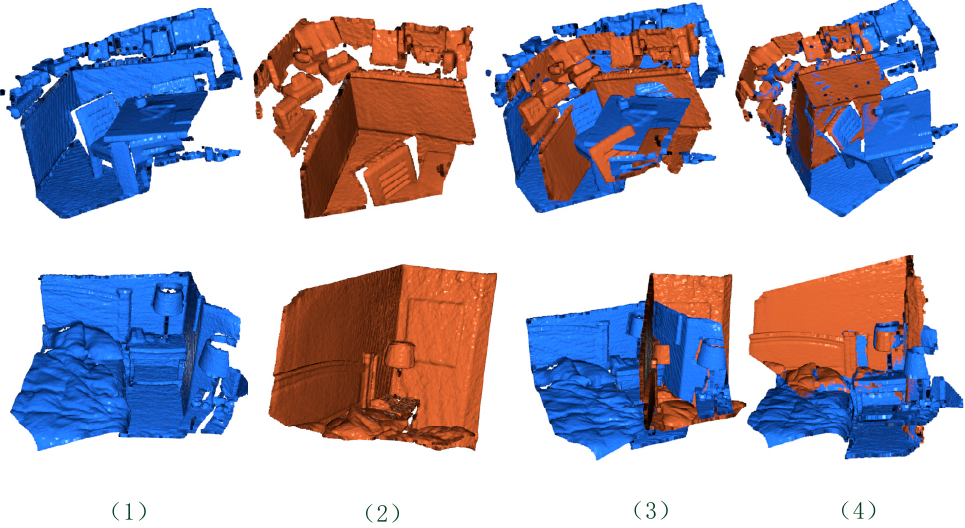
Figure 8. The result on dataset 3DMatch for point cloud registration. ( 1 ) is part one. ( 2 ) is part two. ( 3 ) is an unregistered pair. ( 4 ) is a registered pair.